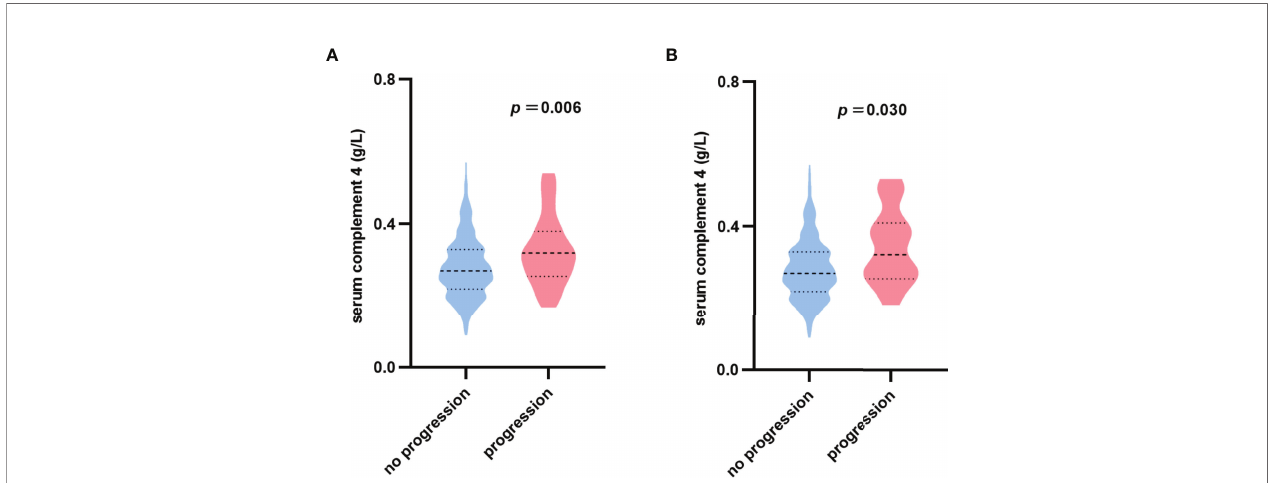
FIGURE 2 | Violin plot of serum complement 4 distribution. (A) No progression: patients without reaching 30% decline in eGFR or ESRD; Progression: patients with reaching 30% decline in eGFR or ESRD. (B) No progression: patients without reaching 50% decline in eGFR or ESRD; Progression: patients with reaching 50% decline in eGFR or